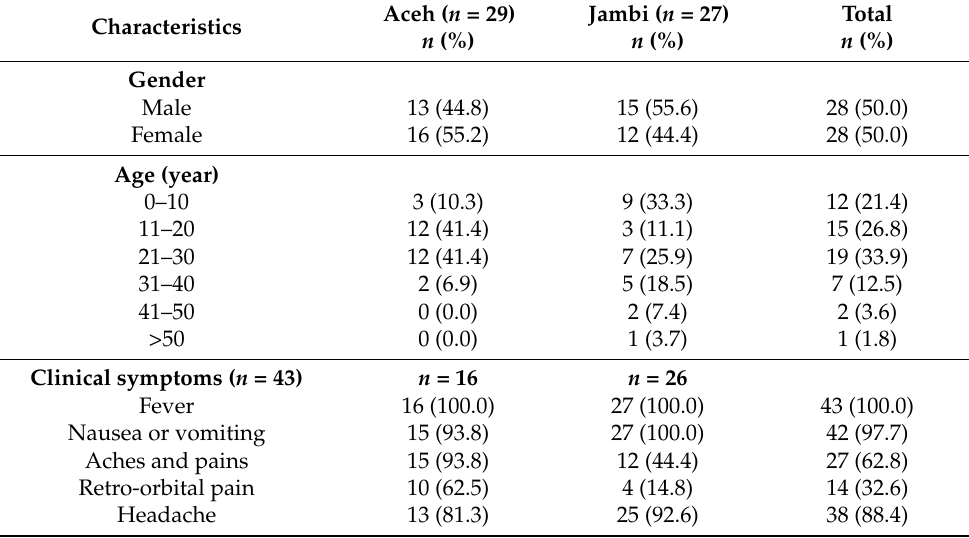
Table 1. Demographic and clinical characteristics of dengue cases in Aceh and